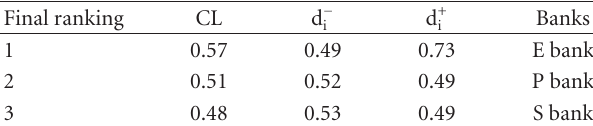
Table 3: Average of fuzzy judgments value of experts.